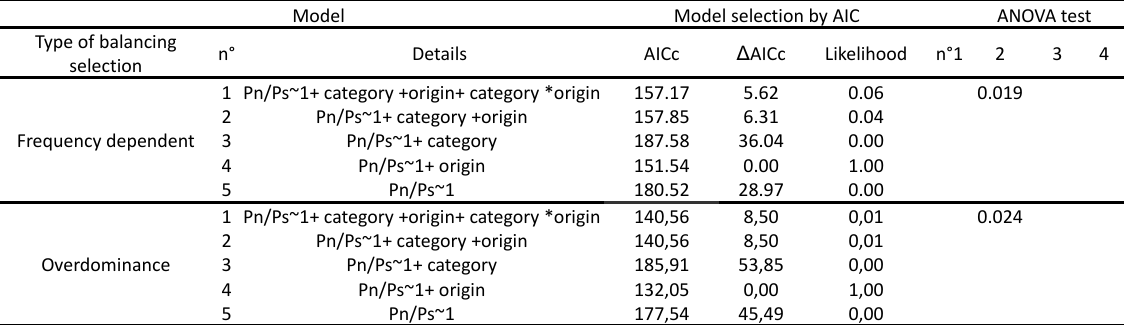
Model Model selection by AIC ANOVA